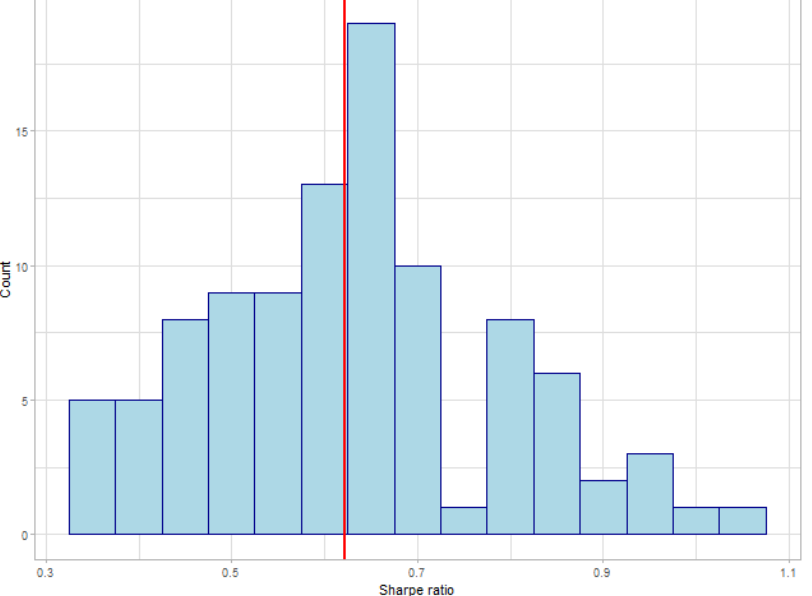
Figure 5. Histogram for Sharpe ratio of 100 trials by using our fuzzy ensemble model. The red vertical line indicates the SP100 index Sharpe